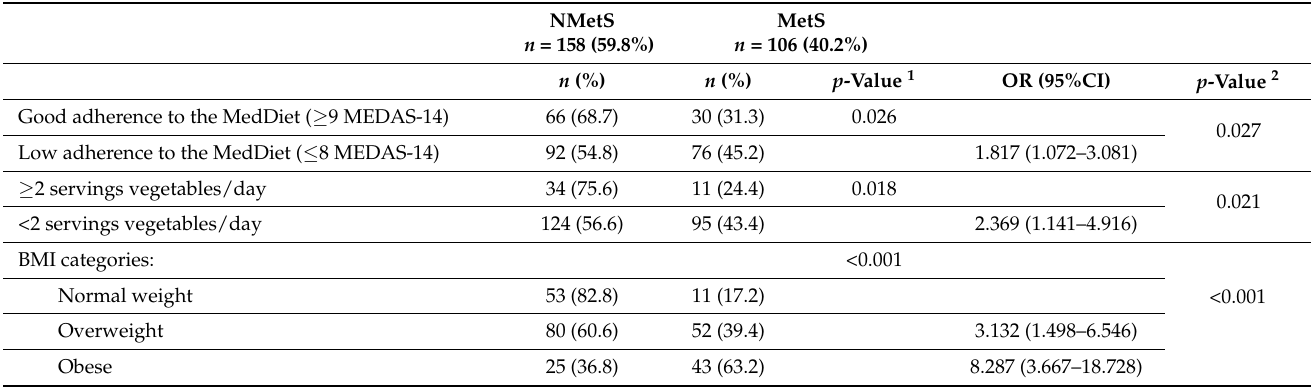
Table 2. Association between the degree of adherence to the Mediterranean diet, vegetable consump- tion, and body mass index level with the prevalence of metabolic